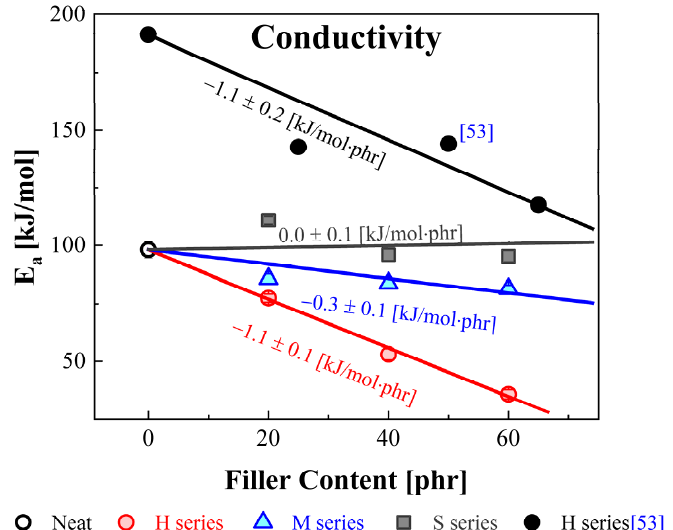
Figure 13. The activation energy for DC conductivity for NBR composites under varying filler loading content. The solid lines and their slopes represent the linear fitting results obtained for the H, M, and S series.